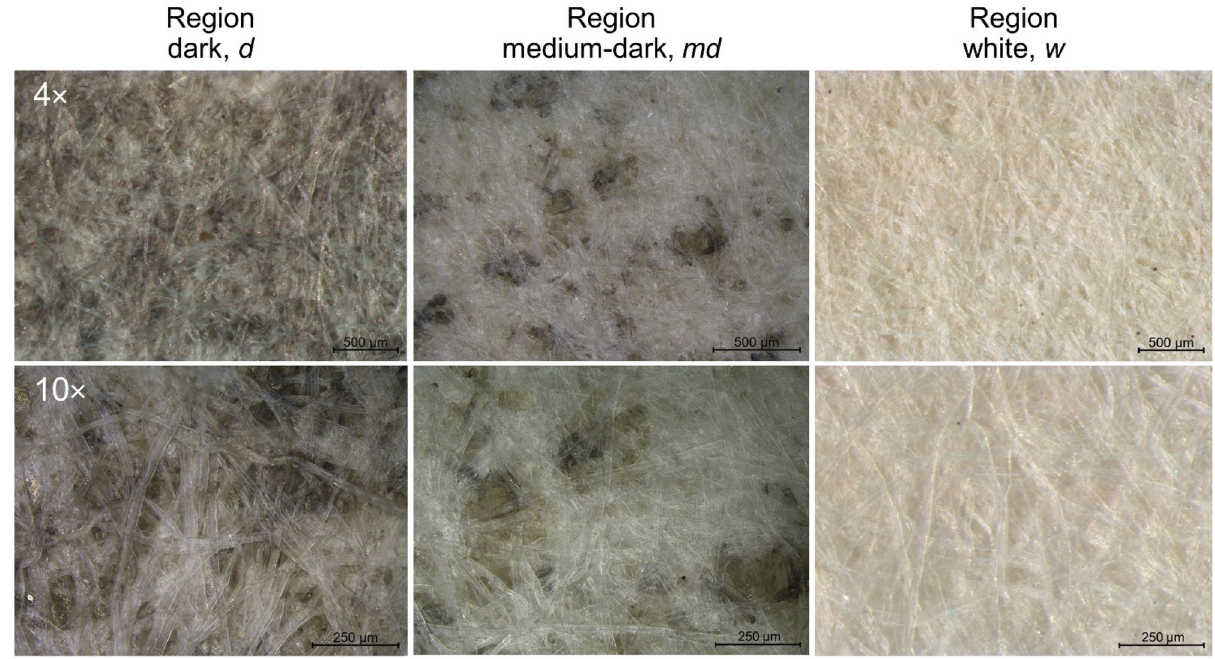
Figure 2. Stereomicroscopy images of the different distribution and density of the black stains in the three regions of the passepartout